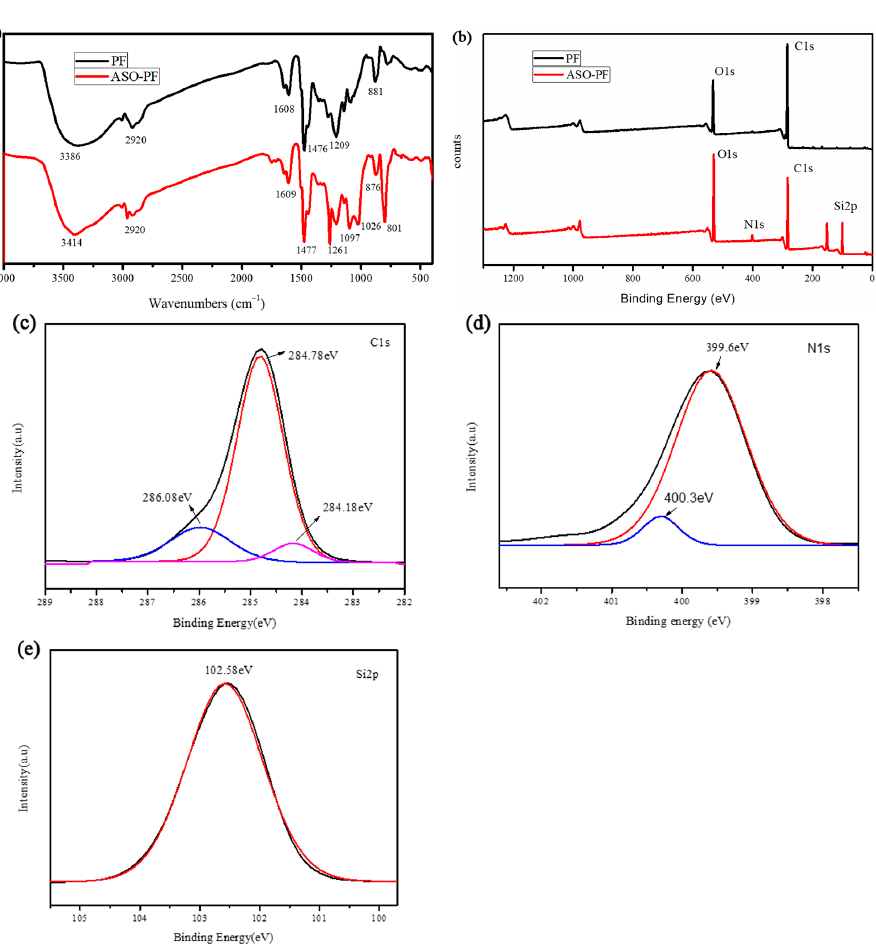
Figure 3. FTIR spectra ( a ), XPS spectra ( b ) of PF and ASO-PF and high resolution C1s ( c ), N1s ( d ), and Si2p ( e ) spectra of ASO-PF.